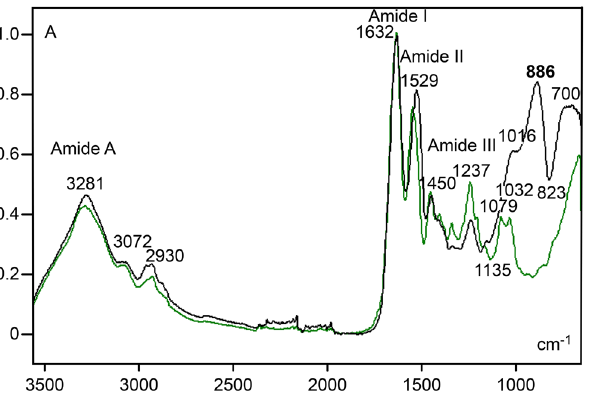
Fig 3. FT-IR spectral profiles for cartilage ECM (black line) and pure collagen type II (green line). See text for details. A, absorbances.